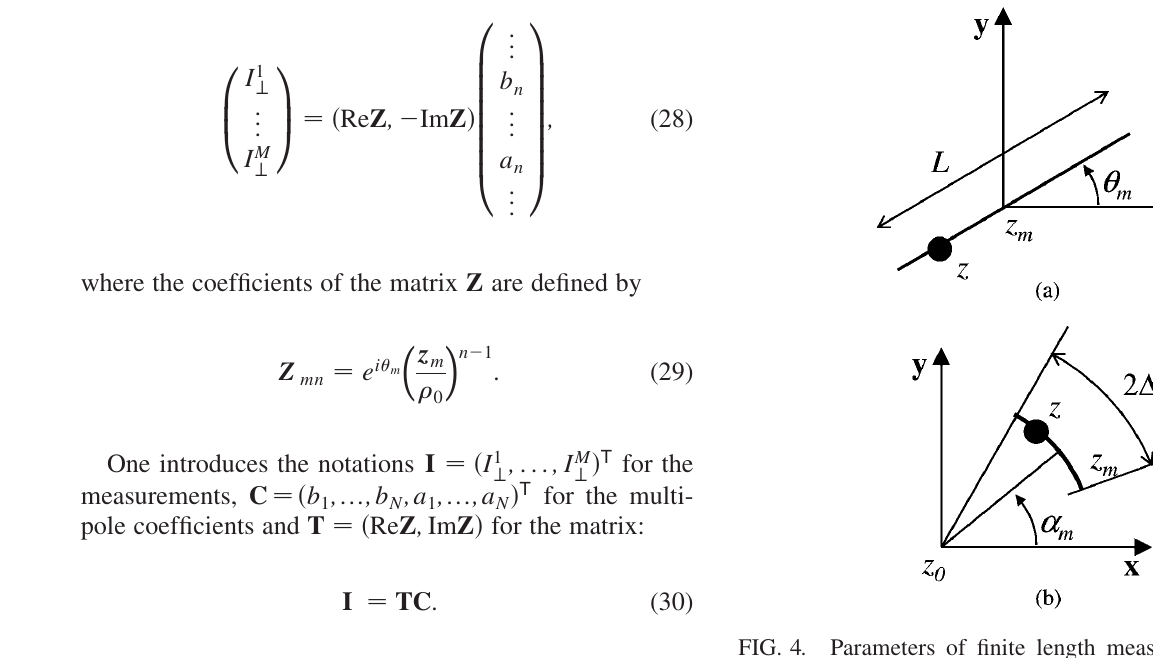
FIG. 4. Parameters of finite length measurements: (a) linear trajectory; (b) circular